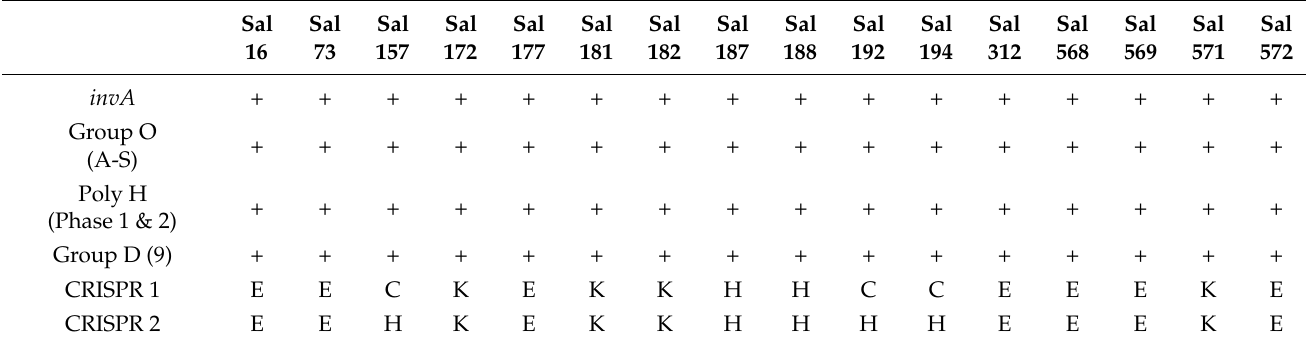
Table 1. Typing of the Salmonella strains used in this